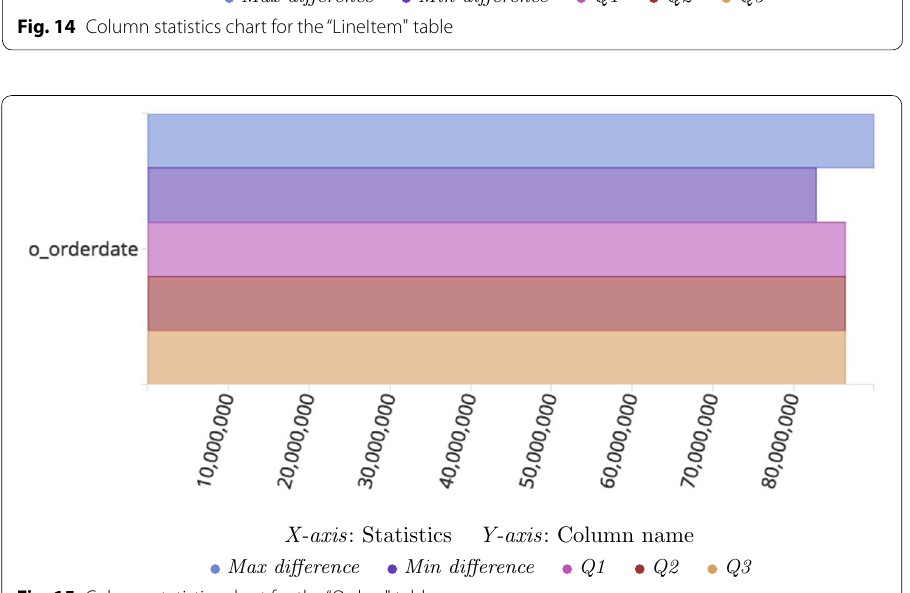
Fig. 15 Column statistics chart for the “Orders"